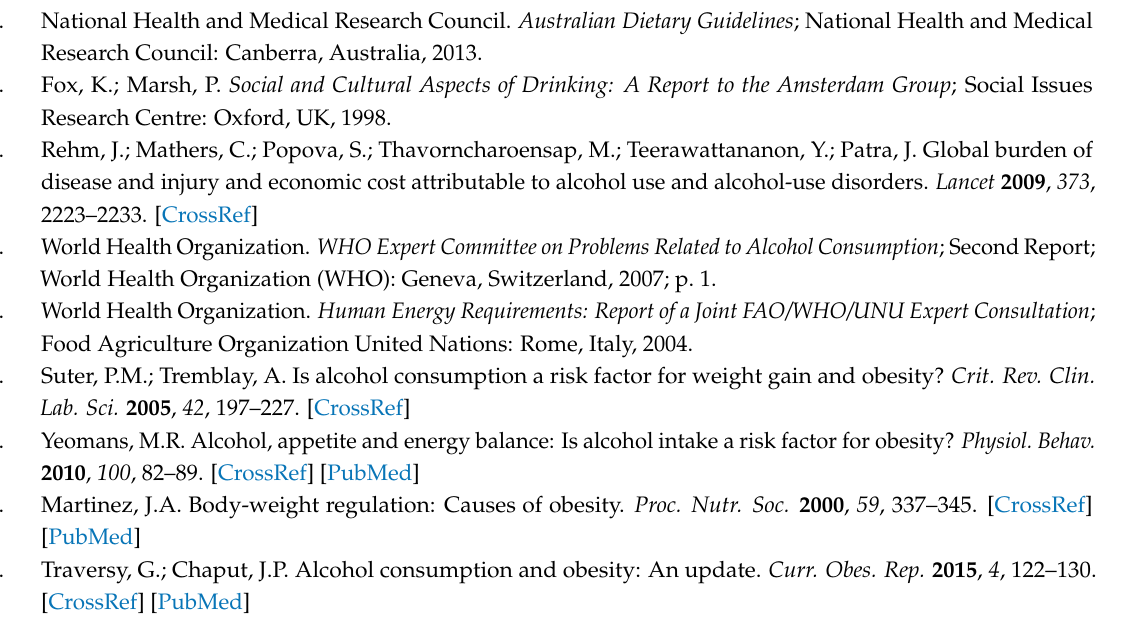
Table S1: Per-consumer median (IQR) energy (%) and alcohol (g) from alcoholic beverages for Australian adults from the National Dietary Survey of Adults-1983 ( n = 5283), the National Nutrition Survey-1995 ( n = 5544) and the National Nutrition and Physical Activity Survey-2011/12 ( n = 4486) excluding low energy-reporters. Acknowledgments: The authors thank the ABS and the National Data Archive for provision of the data